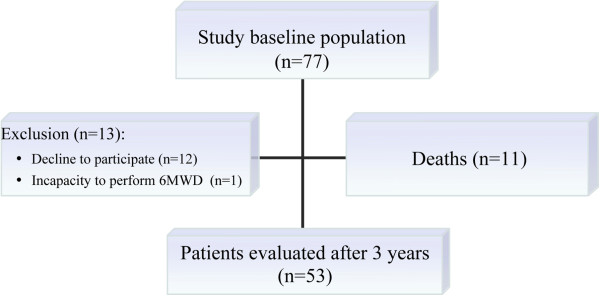
Diagram of patient follow up in three-year period. 6MWD = six-minute walking distance.